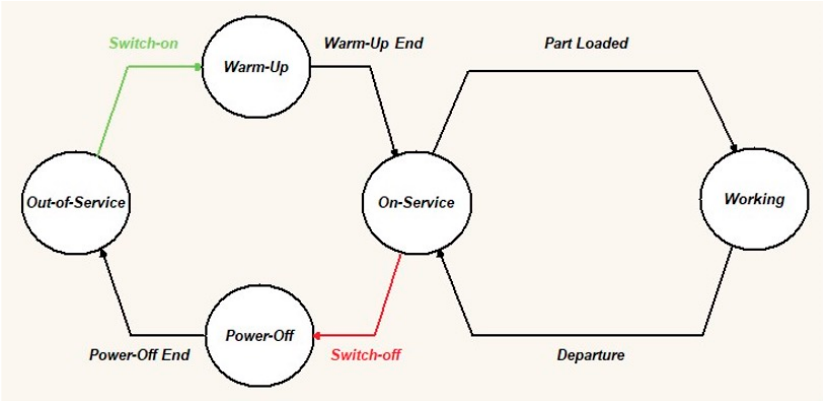
Figure 1. Switch-o ff control. Figure 1. Switch-off